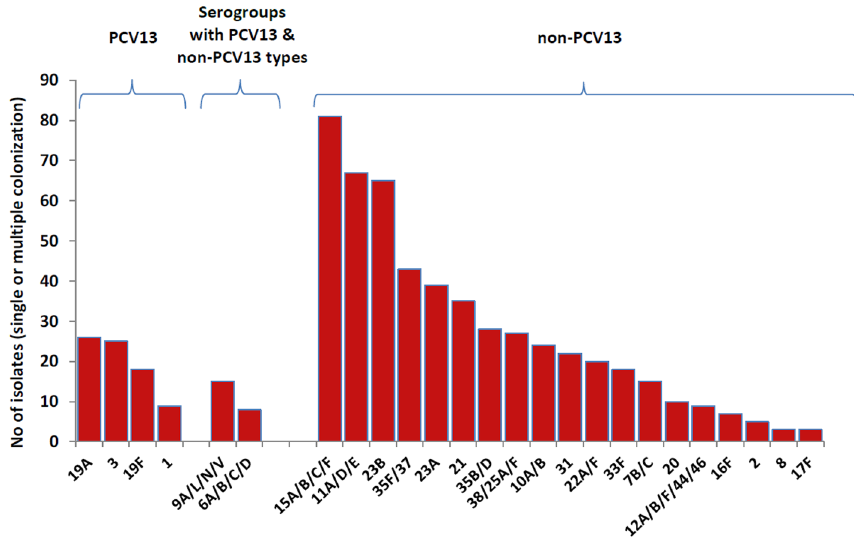
Figure 2. Study serotypes/serogroups revealed according to their inclusion in the PCV13.